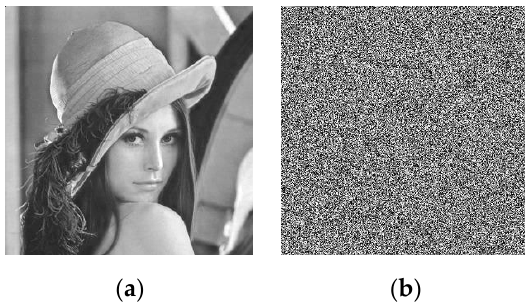
figure (b) that the correct decryption image cannot be obtained after the change of the initial condition − 15 by 10 . Therefore, the encryption algorithm has strong key sensitivity.